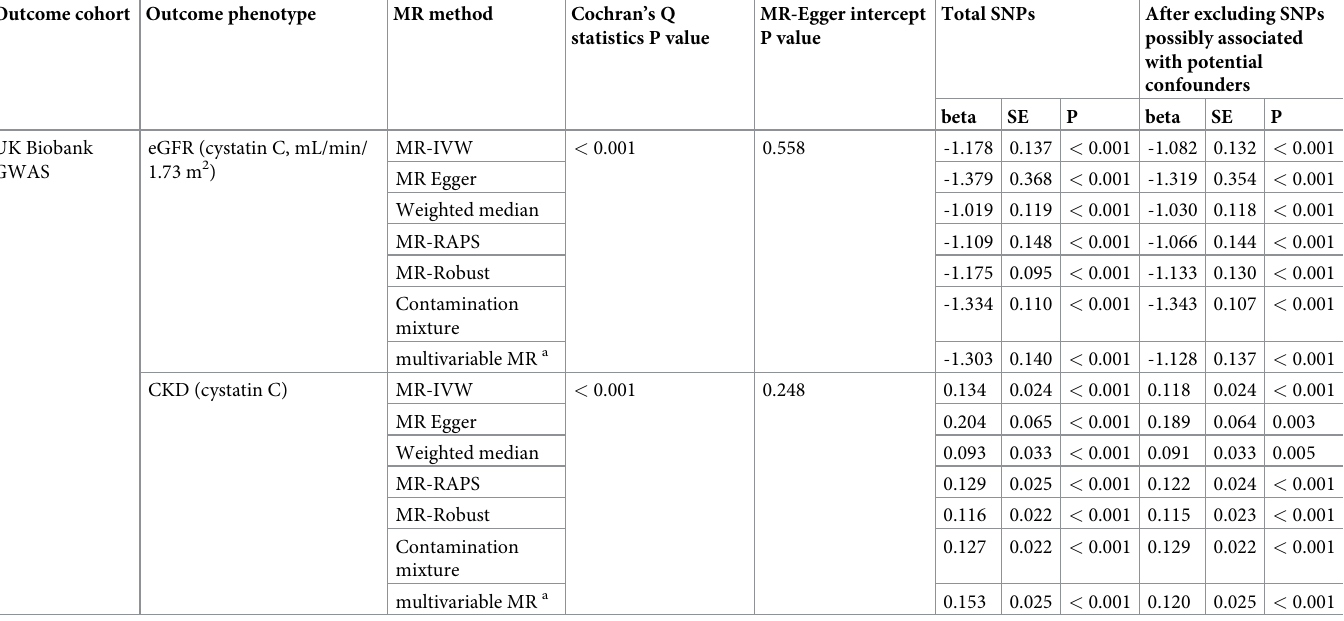
SE = standard error, MR = Mendelian randomization, SNP = single-nucleotide polymorphism, MR-IVW = multiplicative random-effect inverse variance weighting, MR-RAPS = Mendelian randomization robust adjusted profile score, eGFR = estimated glomerular filtration rate, CKD = chronic kidney disease. a Multivariable MR analysis was adjusted for the effects of genetic predisposition on body mass index of variants included in the genetic